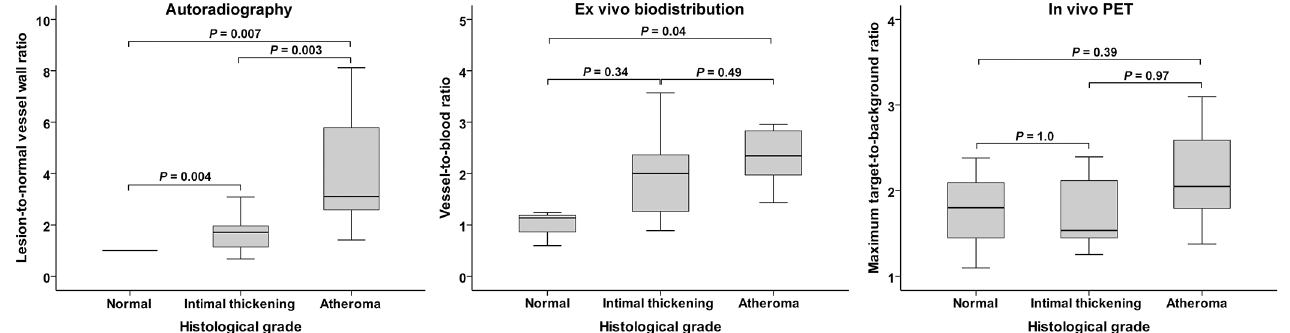
Fig 3. Box plots showing [ 18 F]FDG accumulation in the coronary arteries by autoradiography (A), ex vivo biodistribution analysis (B) or in vivo dual-gated PET/CT imaging (C). Panel A shows [ 18 F]FDG accumulation as an average plaque-to-normal vessel wall ratio as measured by autoradiography at the sites of normal vessel wall, intimal thickening or atheroma. Panel B shows average segmental [ 18 F]FDG accumulation normalized to blood radioactivity in the segments without atherosclerosis, intimal thickening or atheroma plaques. Panel C shows segmental in vivo [ 18 F]FDG signal as the highest target-to- background ratio (TBR) in the segments without atherosclerosis, intimal thickening or atheroma plaques.